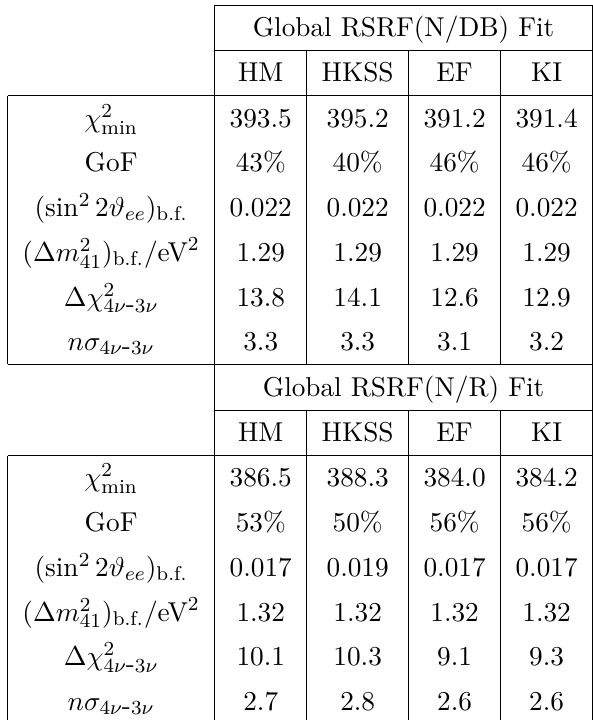
Table 7. Results of the global ν e and ¯ ν e disappearance fits obtained using NEOS/Daya Bay (RSRF(N/DB)) or NEOS/RENO (RSRF(N/R)) data. The column titles HM, HKSS, EF, and KI refer to the four reactor neutrino fluxes discussed in section 3. The table show the minimum value χ 2 of χ 2 , the goodness of fit (GoF) with 390 degrees of freedom (the number of data points minus min two, corresponding to the two fitted mixing parameters), the best-fit values of sin 2 2 ϑ ee and ∆ m 2 the χ 2 difference ∆ χ 2 between the 3+1 4 ν fit and the 3 ν fit, and the statistical significance 4 ν - 3 ν ( nσ 4 ν - 3 ν ) of the corresponding indication in favor of 3+1 4 ν